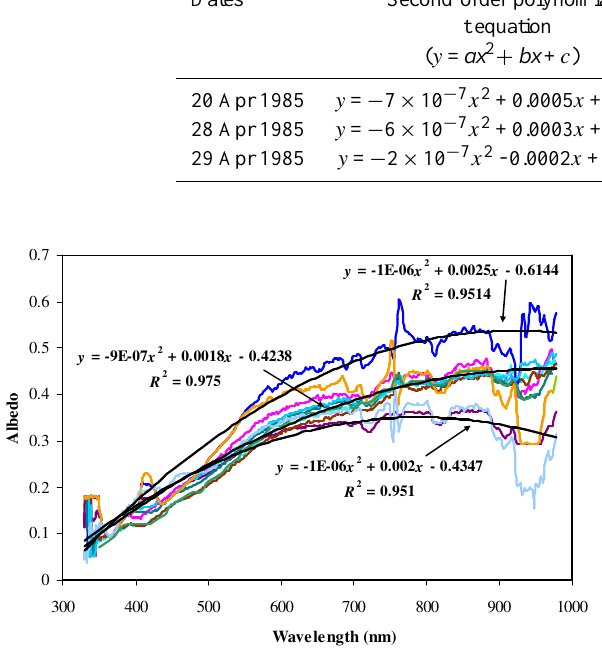
Figure 4. Spectral dependence of the sand albedo. For instance, blue line: measured at the Kara-Kum Desert on 12 October 1983, turquoise line: measured at the Kara-Kum Desert on 13 October 1983, and violet line: measured at the Kara-Kum Desert on 23 Oc- tober 1984.